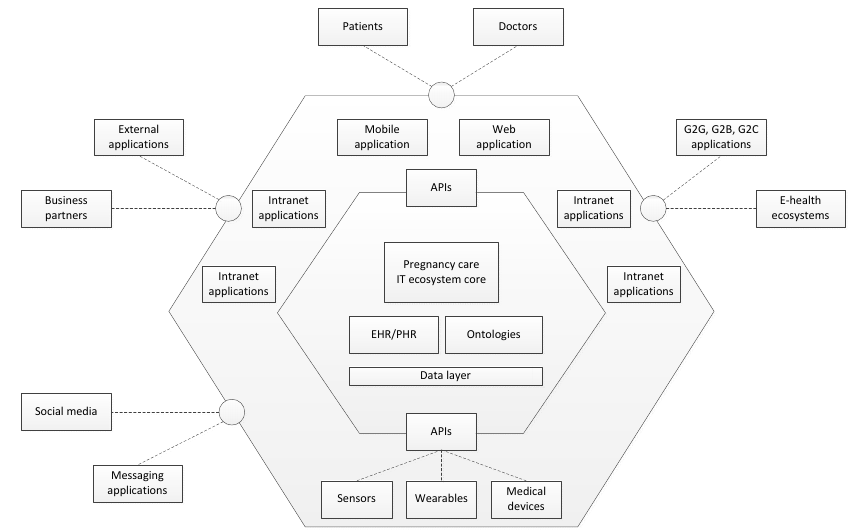
Figure 2. The pregnancy care ecosystem.